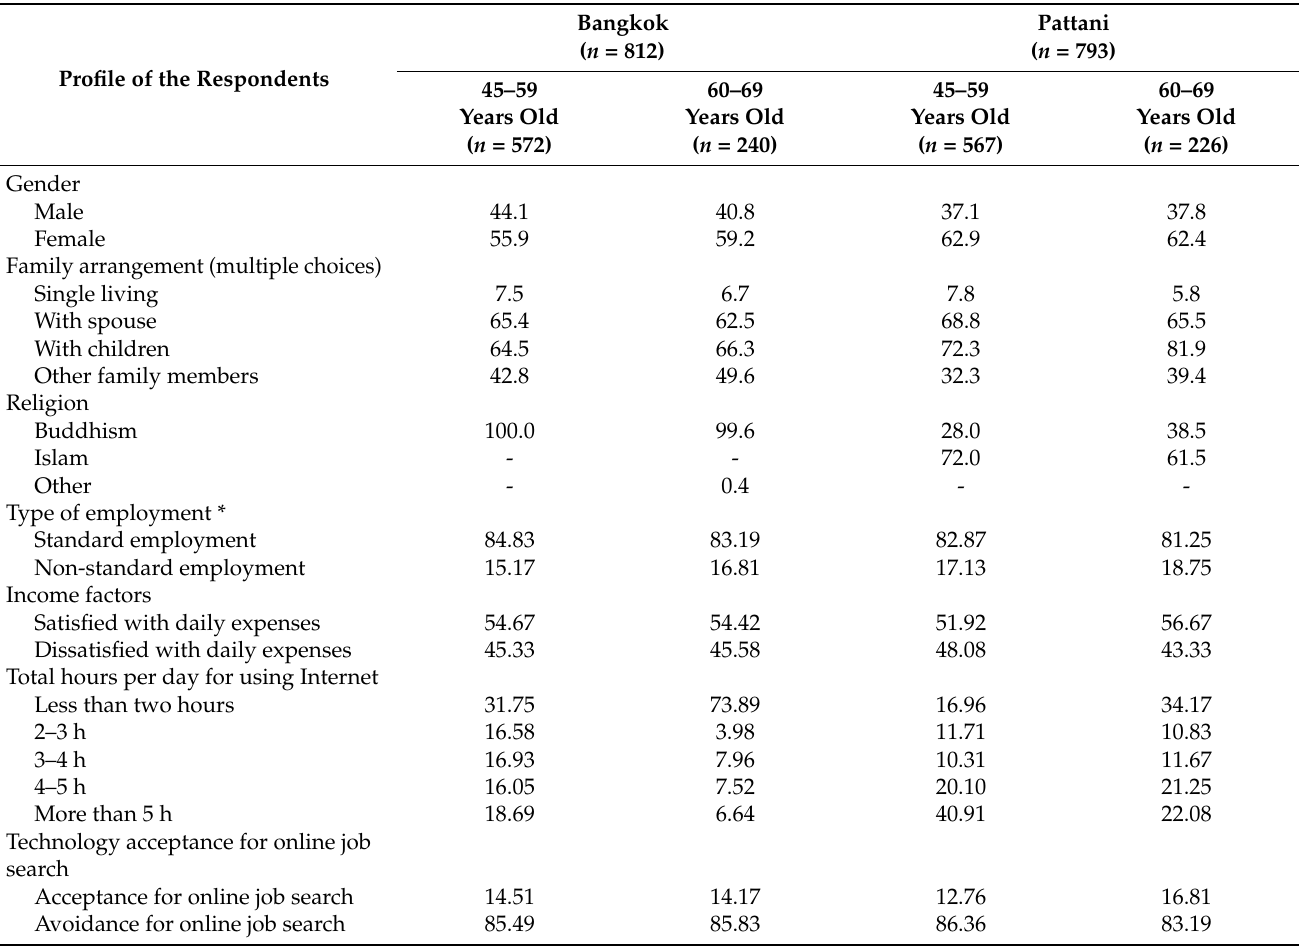
Table 1. Descriptive Statistics. (Unit: